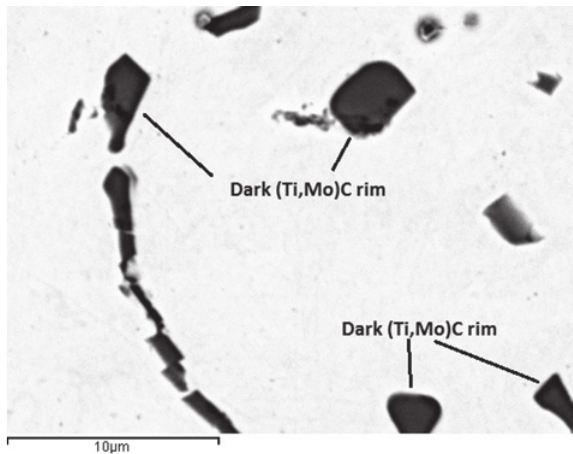
Fig. 14: SEM-BSE image of (Ti,Mo)C particles with a darker outer rim phase in experiment 10 (Fe-TiCMo B 3)